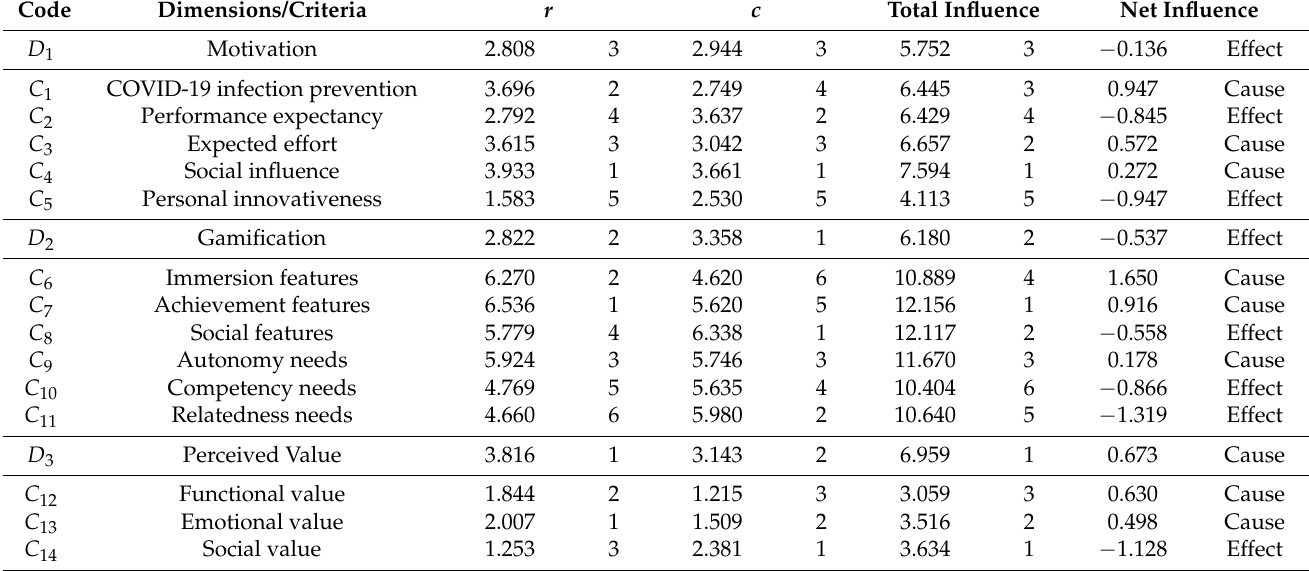
Table 8. The degree of influence of the dimensions and